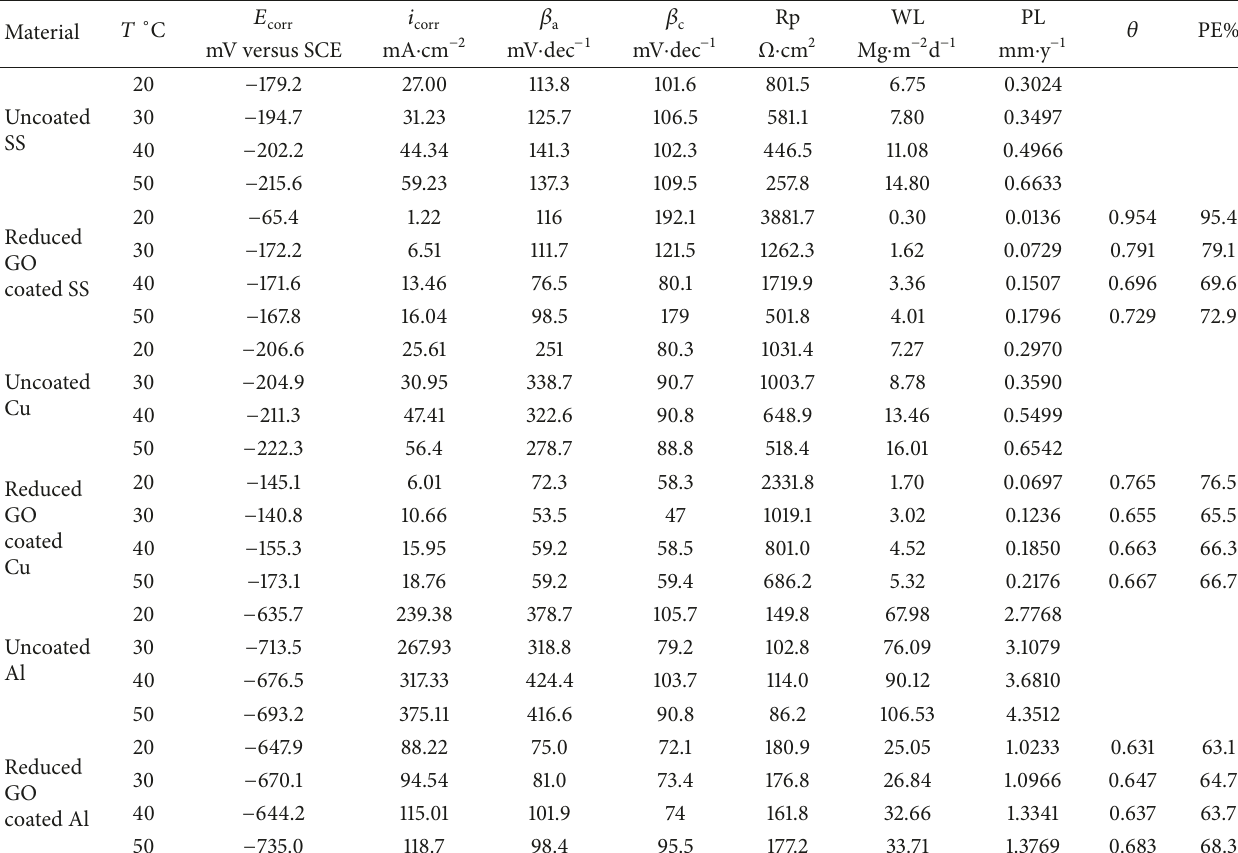
Table 1: Corrosion parameters for uncoated and graphene coated specimens in seawater at different temperature. Material